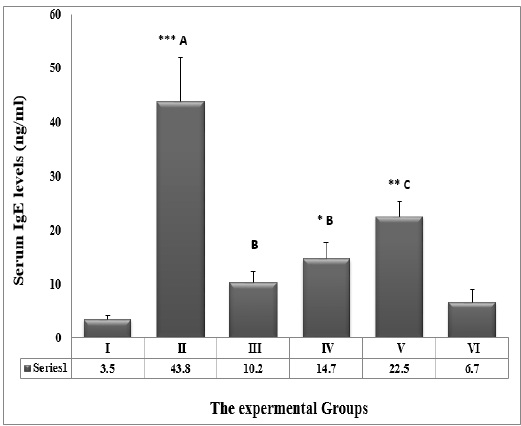
Figure 6. The effect of guggulsterone on IgE levels in the serum of OVA-induced asthma in rats. Values are indicated as means ± Std. Error (n=8) for each group. Group I: Control group, Group II: Positive control group (with sensitization), Group III: Guggulsterone (25 mg/kg) with sensitization, Group IV: Guggulsterone (50 mg/kg) with sensitization, Group V: Prednisolone (4.12 mg/kg) with sensitization, Group VI: guggulsterone (50 mg/kg) without sensitization. *** symbol referred to significant different (p<0.001) compared to control group, unpaired test student t-test. Groups with non- identical letters are significantly different